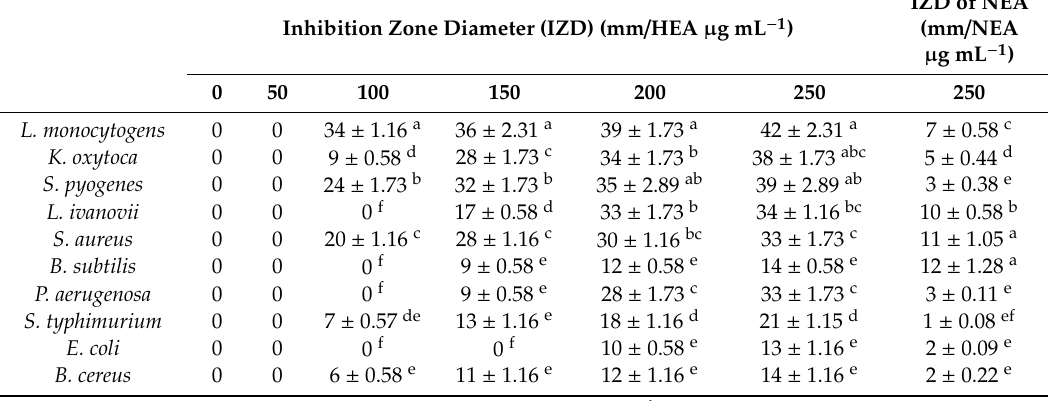
Table 2. Antibacterial activity of pepsin hydrolyzed egg albumin (HEA) using disc di ff usion